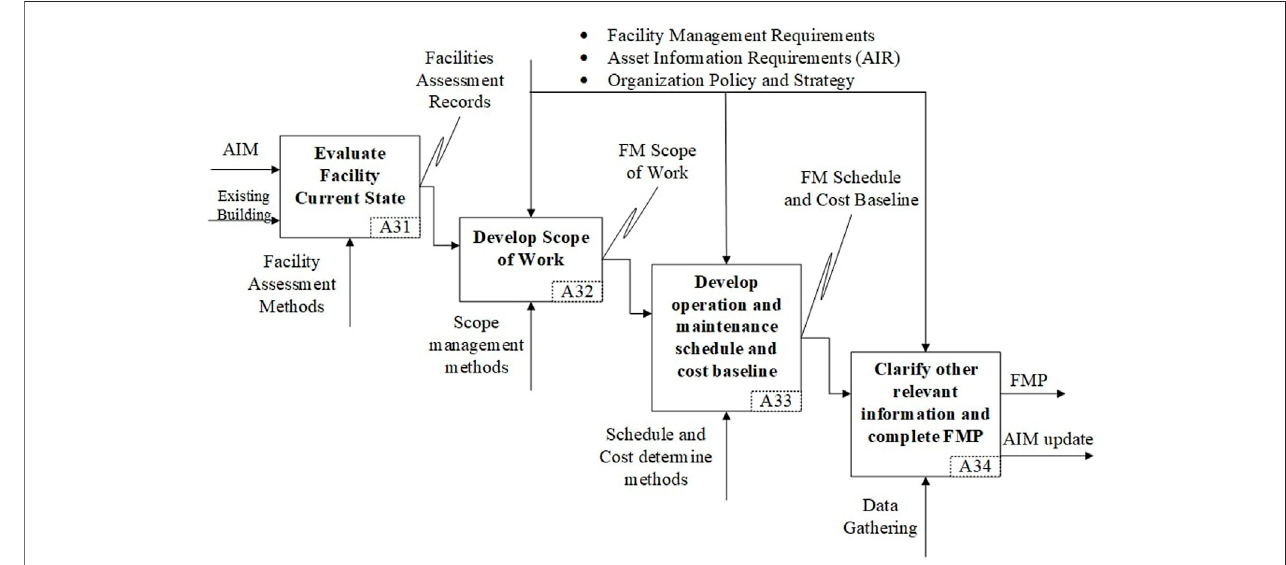
FIGURE 6 | Process model of the development of a facility management plan